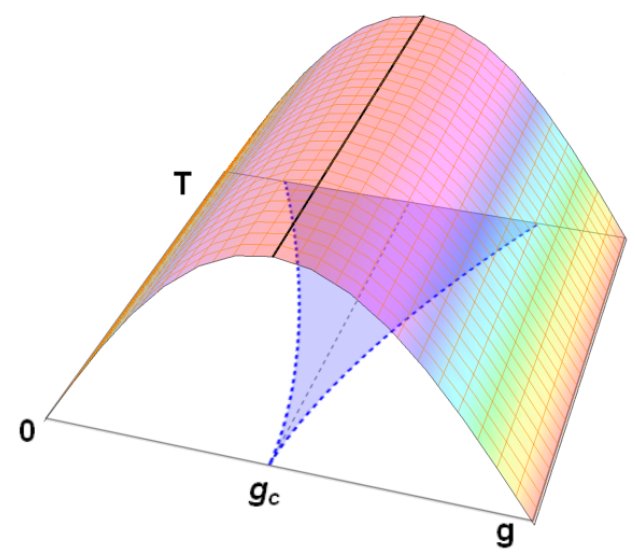
Figure 1. An intuitive sketch of the results of [1] regarding the behavior of the Liapunov exponent (cid:21) L on the quantum critical region (blue region). The exponent (cid:21) L gets its maximum value (black line) at the quantum critical point g = g c . It is not clear, and indeed the purpose of our investigation, if the butter(cid:13)y velocity v B display a similar behaviour or